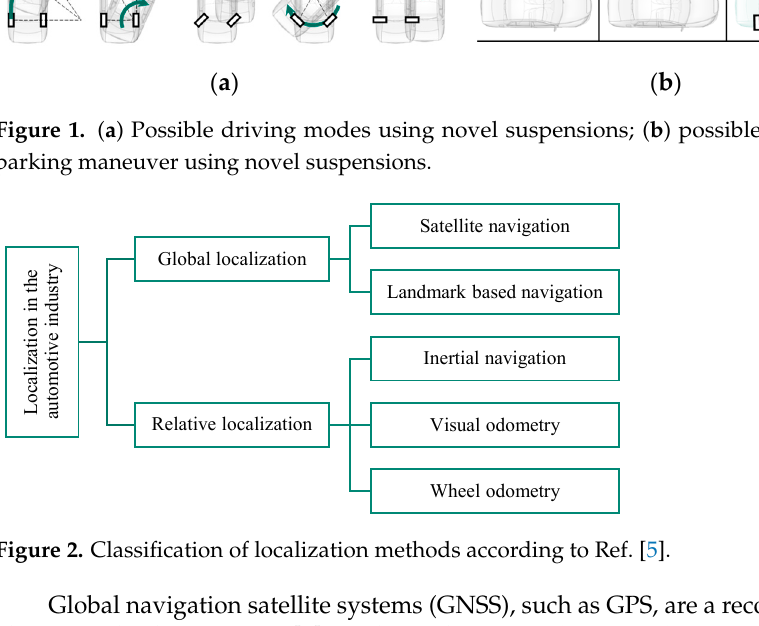
Figure 1. ( a ) Possible driving modes using novel suspensions; ( b ) possible continuously driven parking maneuver using novel suspensions.